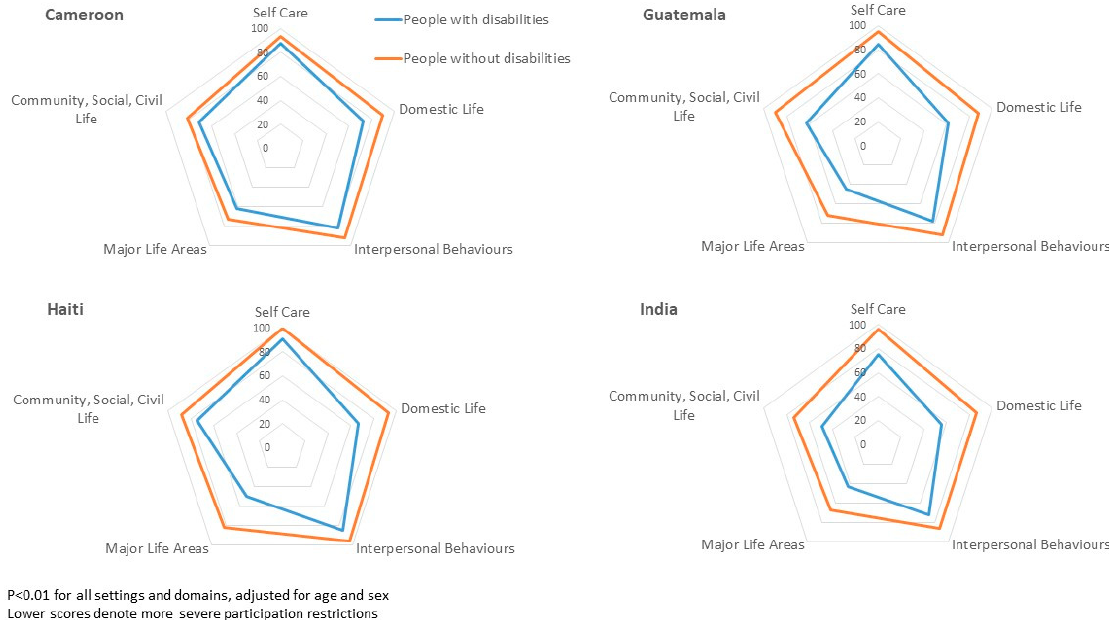
Figure 1. Comparison of participation scores among older adults with and without